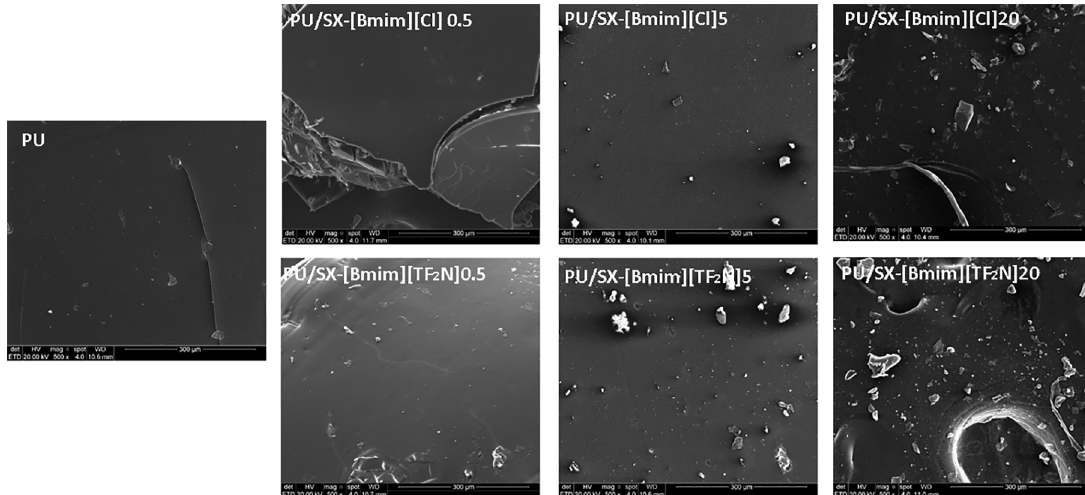
Figure 4. SEM micrographs: a) PU, b) PU/SX-[Bmim] [Cl] 0.5, c) PU/SX-[Bmim] [Cl] 5, d) PU/SX-[Bmim] [Cl] 20; e) PU/SX-[Bmim] [TF